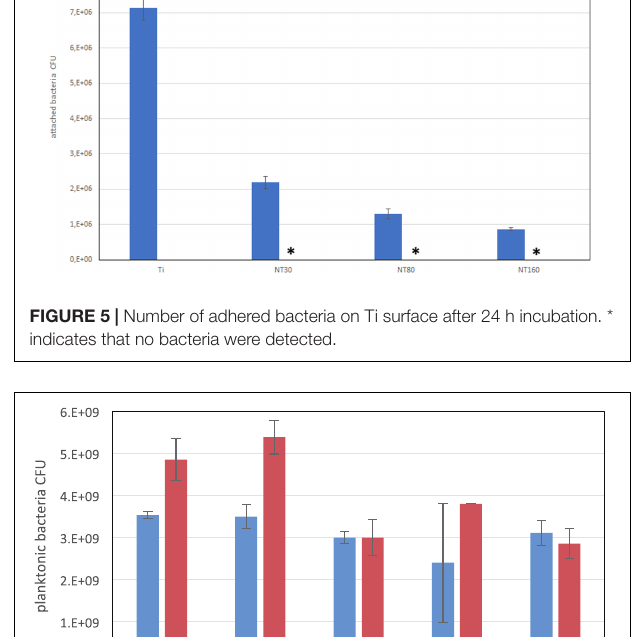
The number of adhered bacteria for gentamicin loaded and unloaded Ti samples after 24 h incubation is shown in Figure 5